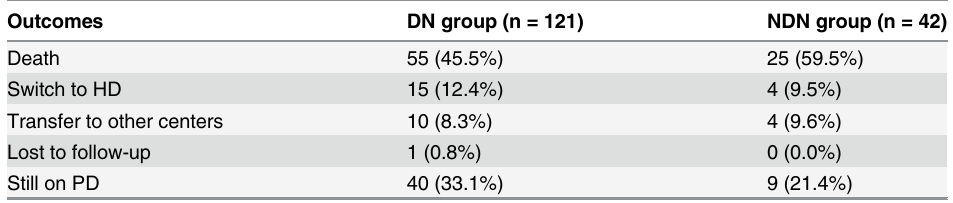
Table 3. Outcomes of DN group and NDN group.